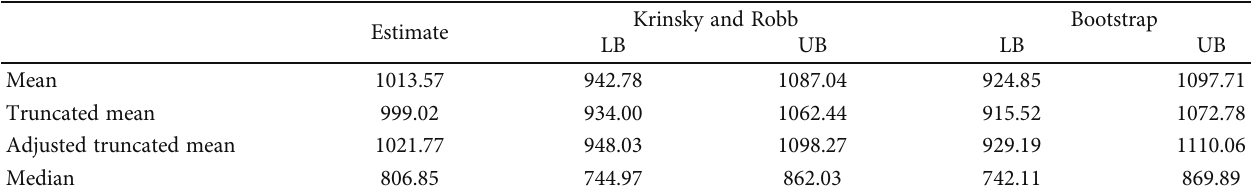
Table 13: Con fi dence intervals for the WTP of the Weibull model (source: authors).